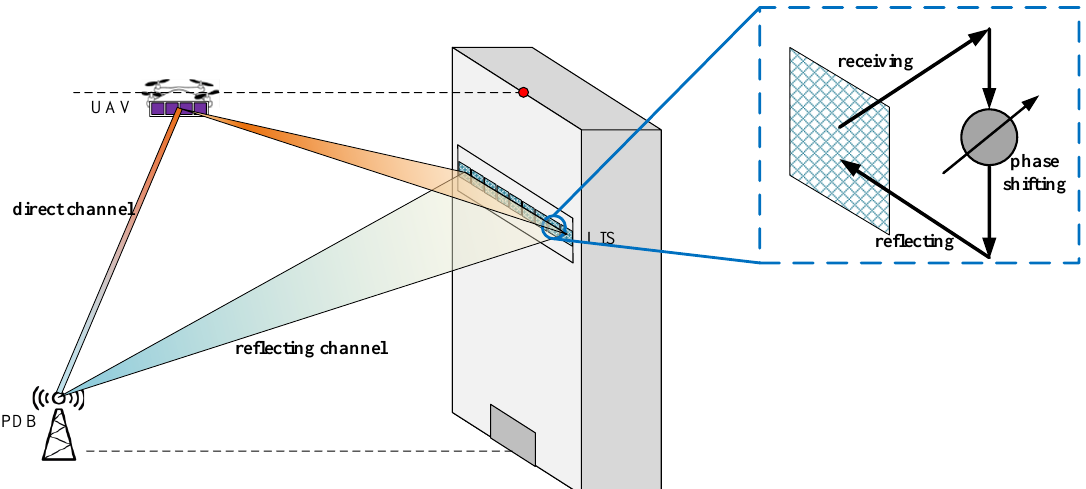
Figure 3. The scene of LIS-assisted multiple input single output (MISO)